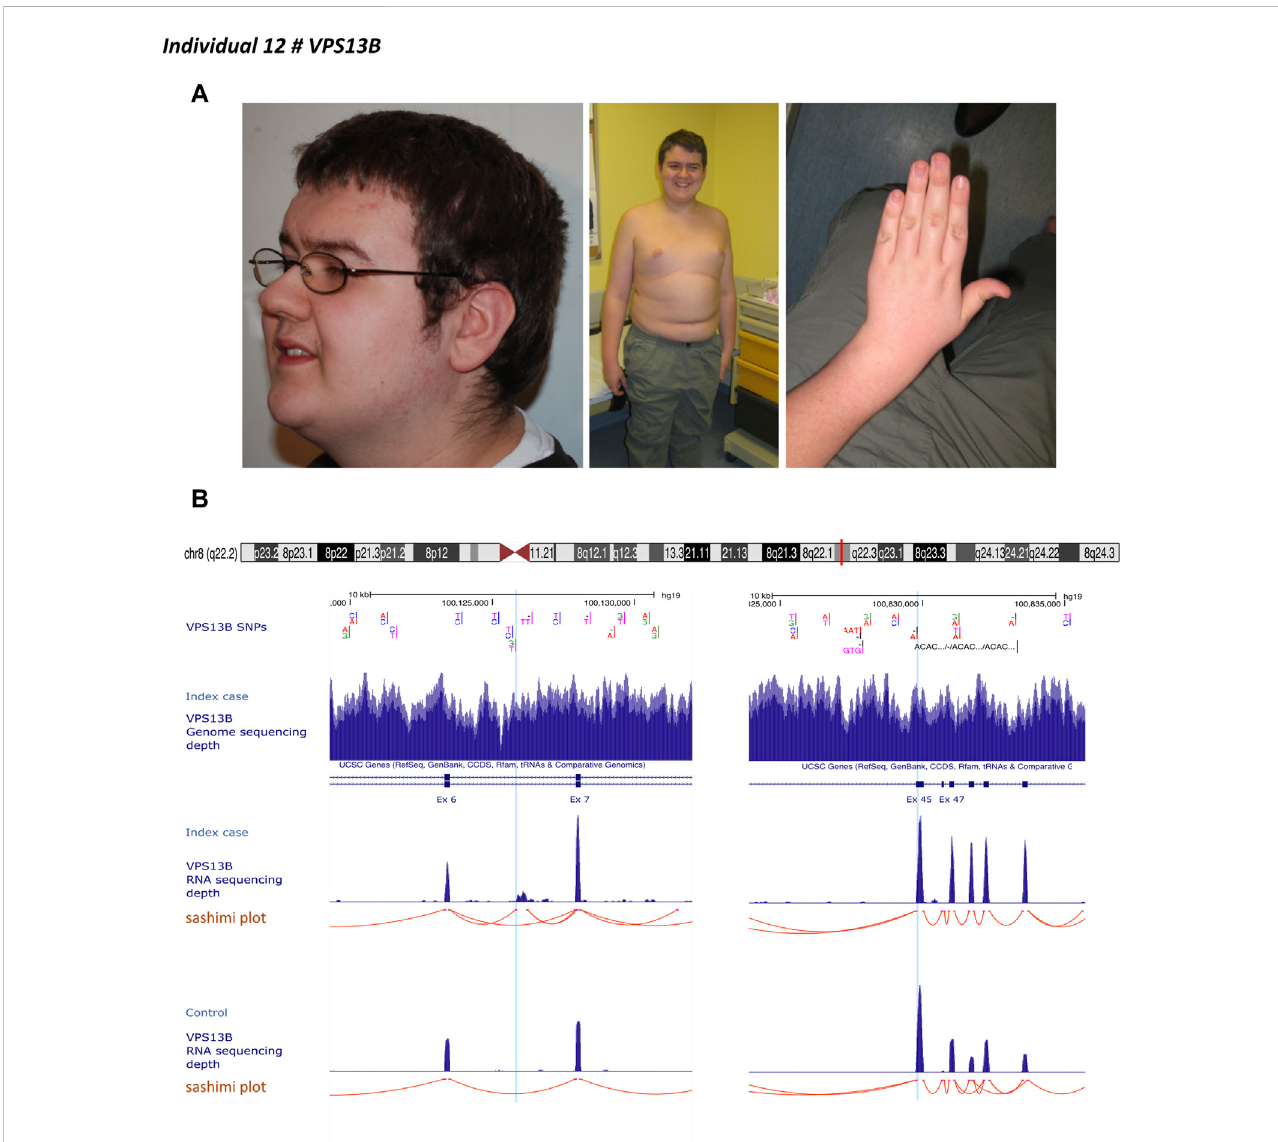
FIGURE 3 Individual12 — Cohensyndrome,MIM216550. (A) Dysmorphicfeaturesincludedown-slantingpalpebral fi ssures,midfaceretrusion,shortphiltrum,open mouth appearance, high palate, micrognathia, truncal obesity, narrow hand with tapered fi ngers, and joint hyperextensibility. (B) Ideogram showing chromosome 8 and VPS13B localization. UCSC genome browser snapshot with visualization of VPS13B single nucleotide polymorphisms (SNP), VPS13B sequencing depth, VPS13B RNA-sequencing depth and splicing analysis (sashimi plot) in individual 12 and a healthy individual (control). Left panel, visualization of the deep intronic heterozygous variant (NC_000008.10:g.100125810G > T) in intron 6, indicated by a light blue line and corresponding to the beginning of the cryptic exon. Red lines indicate spice events. This variant resulted in the creation of an acceptor splice site visualized on the splice analysis tract. The right panel shows the variant inherited from the mother indicated by the light blue